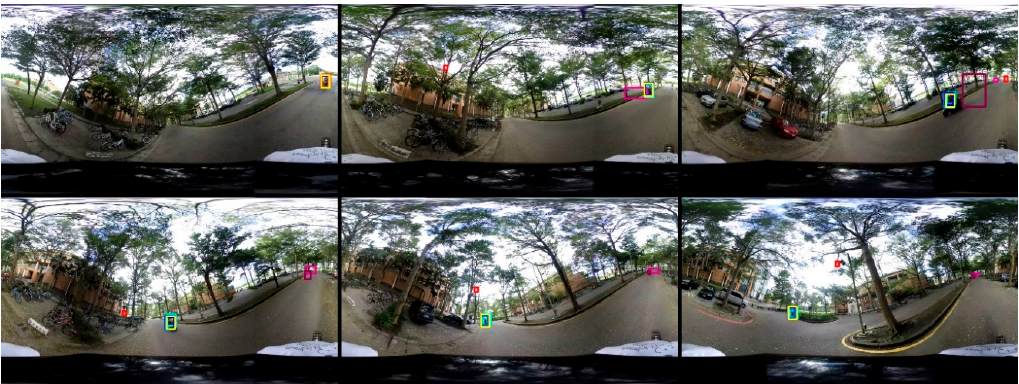
Figure 4. Tracking results on 360-degree video sequence 1 (tracking windows with di ff erent colors: MOSSE MIL MedianFlow BOOST TLD KCF GOTURN